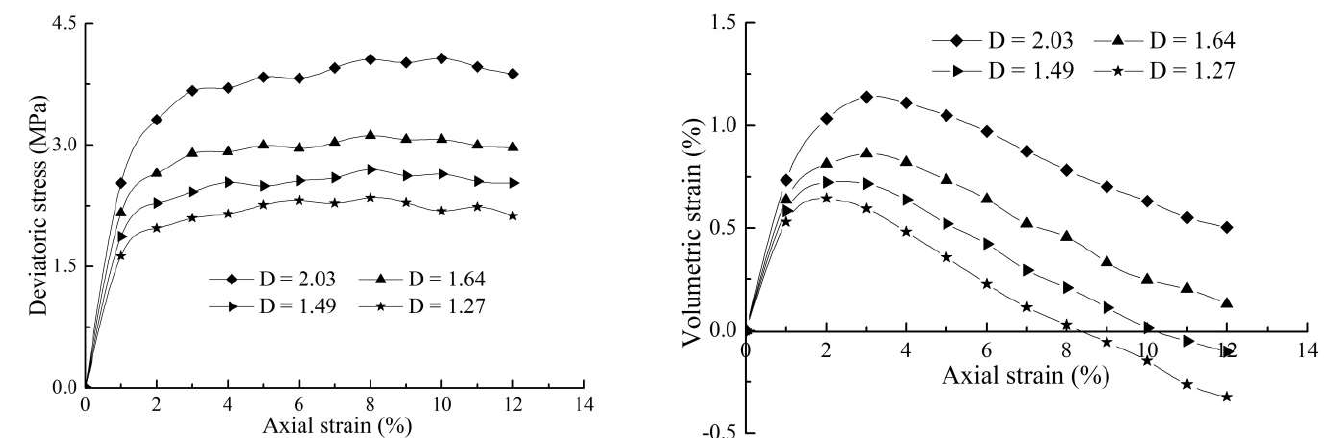
Figure 4. Relation curves of deviatoric stress and volumetric strain with axial strain under different fractal dimensions.